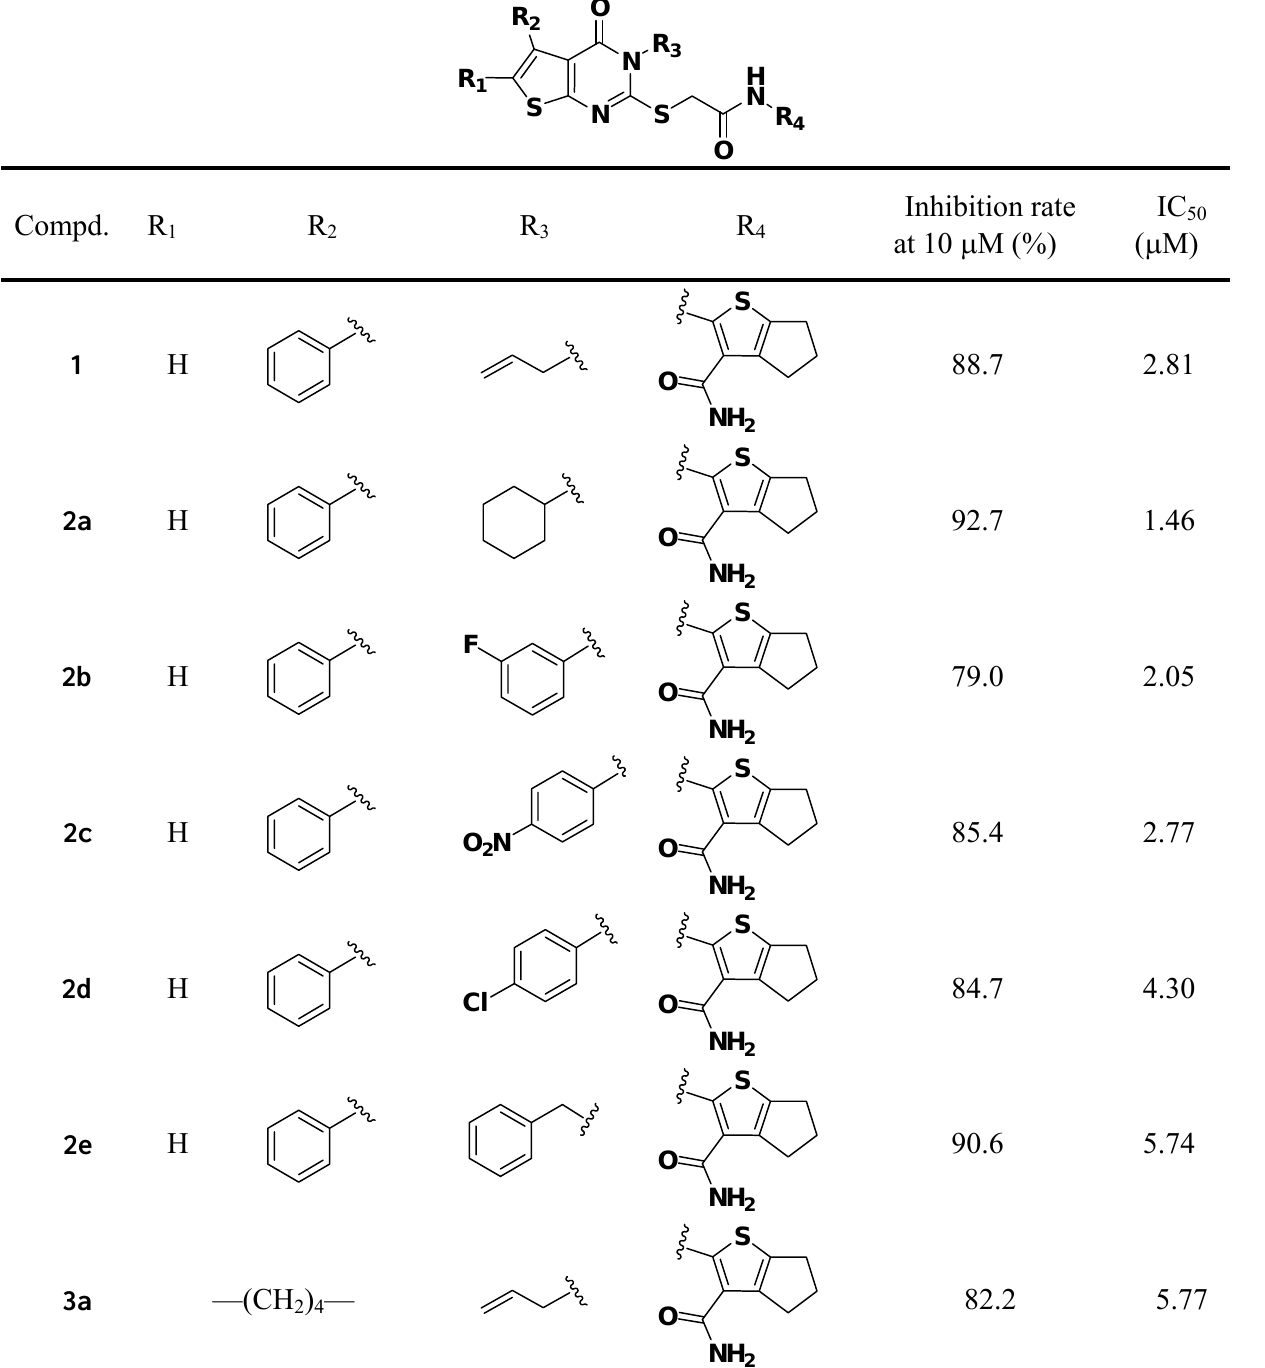
Table 1. Chemical Structures of Compounds 1 , 2a - e , 3a - c and 4a - f and Their Inhibitory Activities against FP-2.